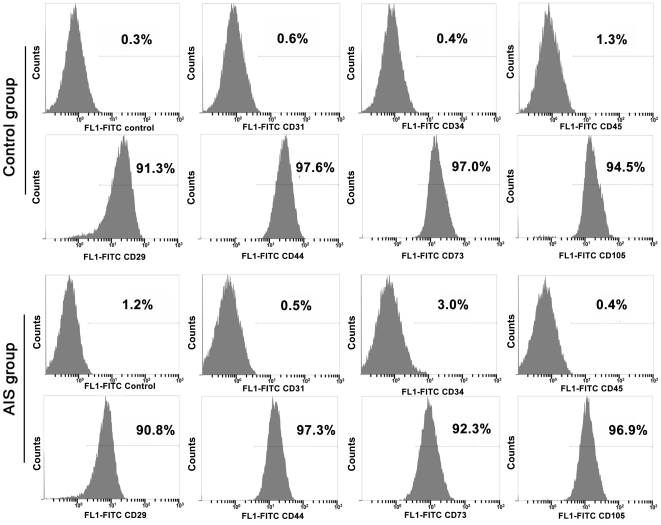
The immunophenotypes of MSCs from control and AIS groups.The figure shows immunophenotypes of MSCs isolated from non-AIS patients with lower-leg fracture (control) and AIS patient detected by FACS.